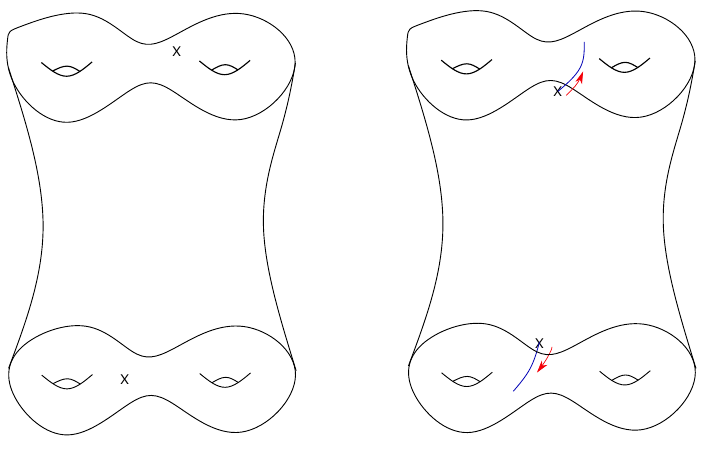
Figure 1: A genus-2 wormhole on which we compute correlation functions. On the left, the situation where the symmetry in the bulk is not gauged. This yields a non- zero correlation function. On the right, the situation where the symmetry is gauged in the bulk. In this case the field theory operators can be interpreted, using the ex- trapolate AdS / CFT dictionary, as the boundary limit of the bulk operator insertions which are attached to Wilson lines that end on the respective boundary. This corre- lation function